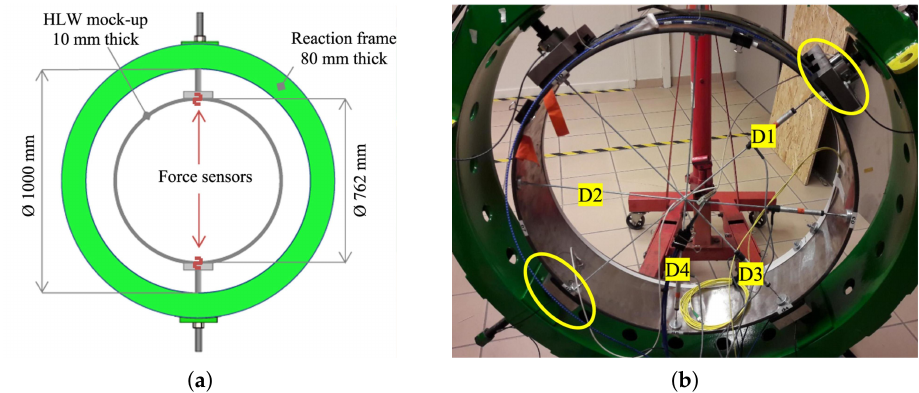
Figure 4. Test mock-up. ( a ) Scheme of the mock-up. ( b ) Full experimental setup: reaction frame (in green) with instrumented metallic ring. In detail the four displacement sensors “D#” and the load application runners (yellow